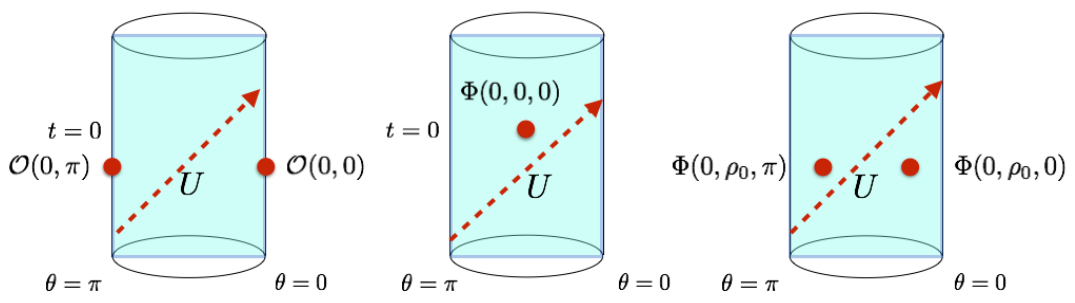
Figure 2 . The con(cid:12)gurations of double trace deformations we consider in this paper. (Left) Double trace deformation composed of boundary local operator.(Center) Single trace deformation in the bulk. (Right) Double trace deformation pushed into the